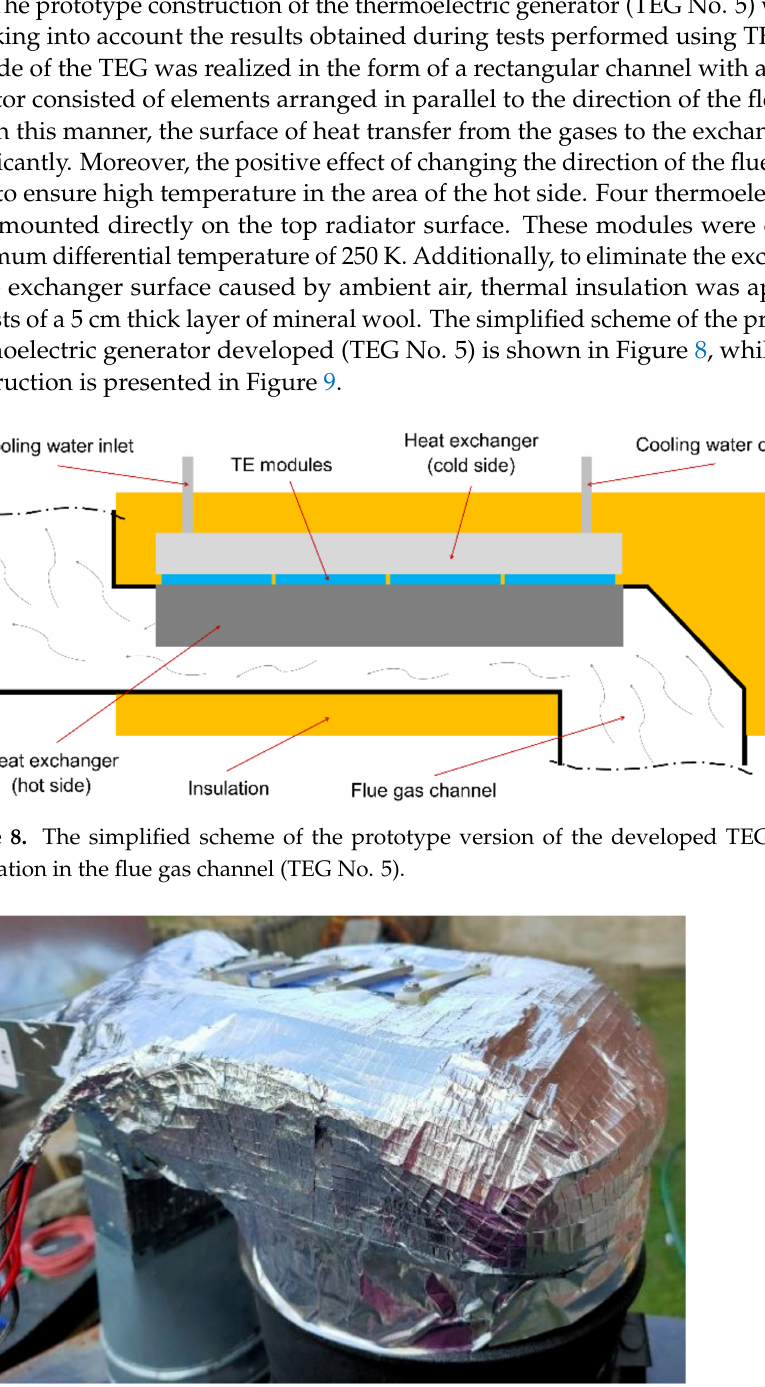
Figure 9. The preliminary construction of the prototype version of the developed TEG dedicated for installation in the flue gas channel (TEG No.